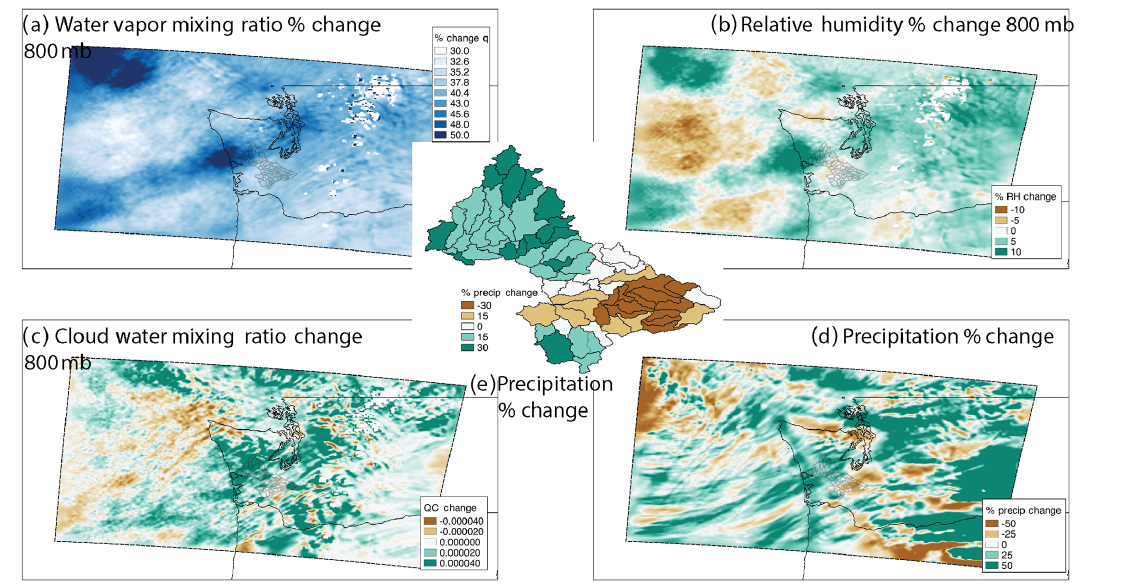
Figure 8. Changes between WRF-PGW for the upper scenario and WRF-control (inner WRF domain) averaged for the 1–4 December period for (a) water vapor mixing ratio percent change at 800mb, (b) relative humidity percent change at 800mb, (c) absolute change in cloud water mixing ratio at 800mb and (d) percent change in precipitation; (e) percent precipitation change area averaged over all Chehalis sub-basins of the HEC-HMS model.